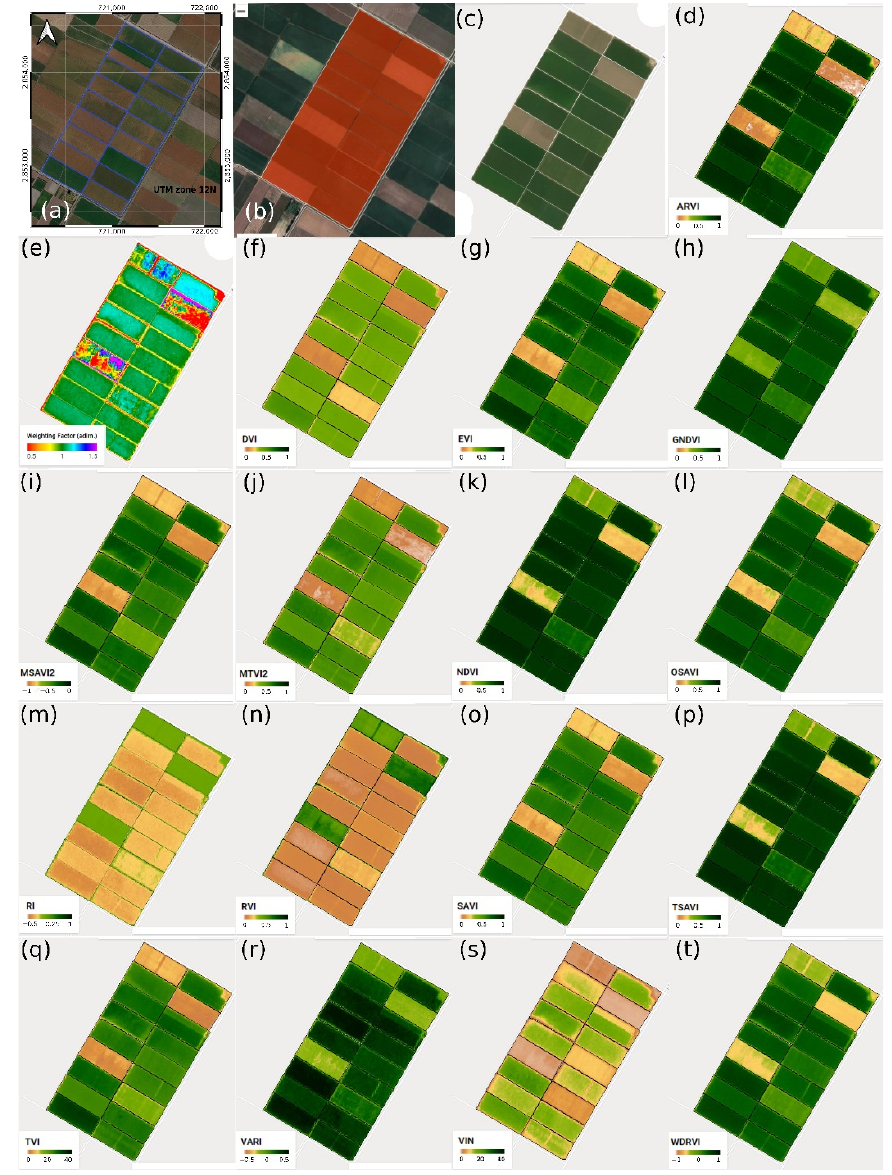
Figure 5. ( a ) Location of parcels in Northern Sinaloa, Mexico; ( b ) 18 polygons drawn in VICAL; different maps obtained in VICAL (date: 3 April 2020): ( c ) RGB combination; ( d ) ARVI; ( e ) weighting factor for ARBI; ( f ) DVI; ( g ) EVI; ( h ) GNDVI; ( i ) MSAVI2; ( j ) MTVI2; ( k ) NDVI; ( l ) OSAVI; ( m ) RI; ( n ) RVI; ( o ) SAVI; ( p ) TSAVI; ( q ) TVI; ( r ) VARI; ( s ) VIN; ( t )